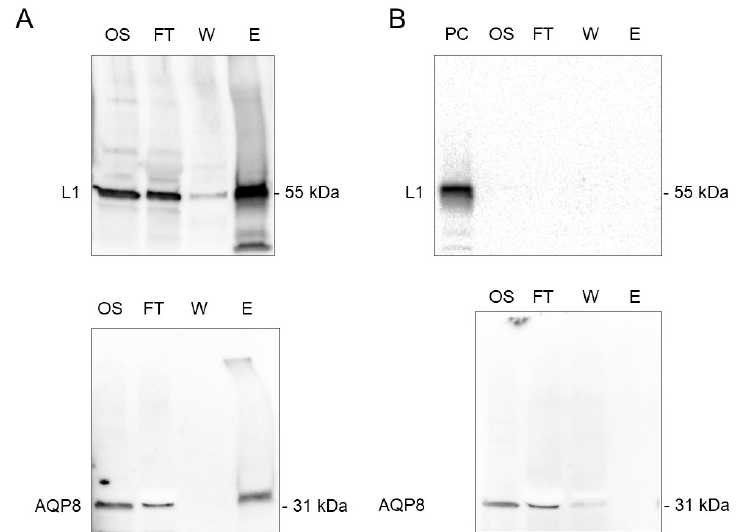
Figure 4. Representative immunofluorescence confocal microscopy images of AQP3, AQP7, and HPV in human sperm. Green labeling indicates the presence of HPV, red labeling the expression of AQP3 or AQP7, while nuclei were counterstained by DAPI (blue). Merged pictures are shown. No colocalization (no yellow signal) was observed for either AQP3 or 7 and HPV. Scale bar, 5 μ m.